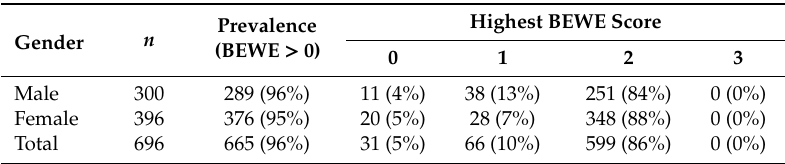
Table 4. Prevalence and severity of erosive tooth wear.